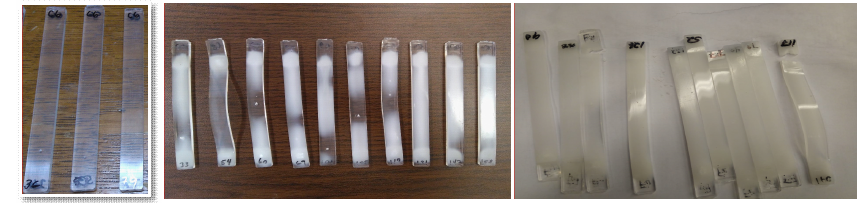
Figure 1. Intersection point in time and 10% of